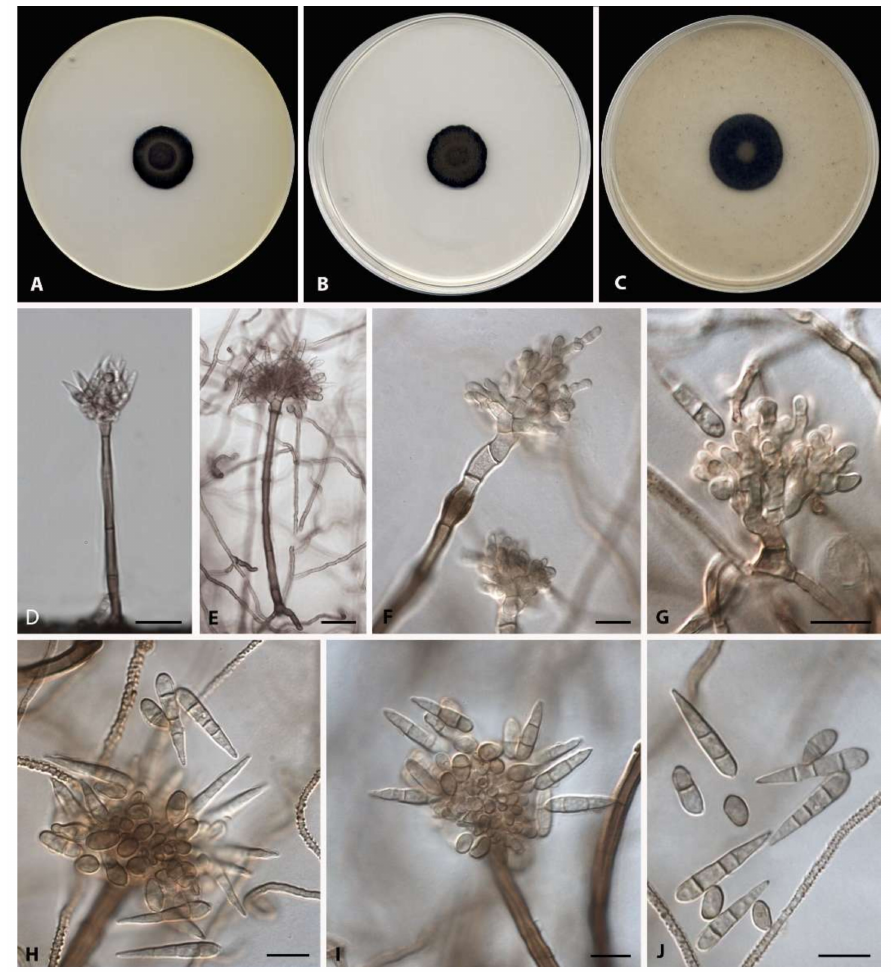
Figure 2. H. variabilis (ex-type FMR 17592). ( A – C ). Colonies on potato dextrose agar (PDA), potato carrot agar (PCA), and oatmeal agar (OA), respectively, after 30 days at 25 ◦ C. ( D – J ). Conidiophores and conidia. Scale bars: ( D , E ) = 20 µ m; ( F – J ) = 10 µ m. Etymology: Name refers to the variation in the conidial